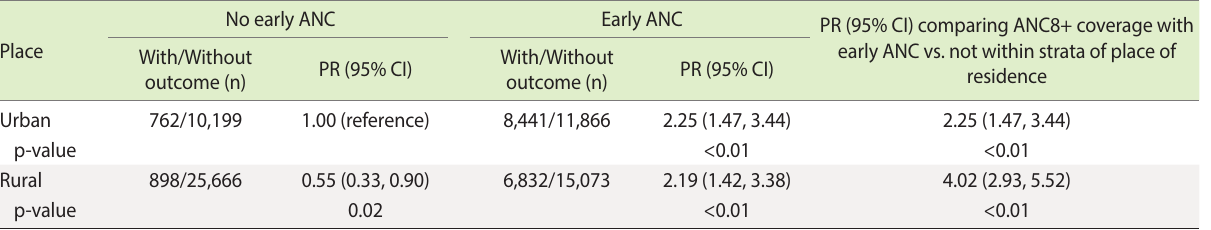
Table 3. Effect modification 1 of the association between early ANC and ANC8+ by place of residence 2 No early ANC Early ANC PR (95% CI) comparing ANC8+ coverage